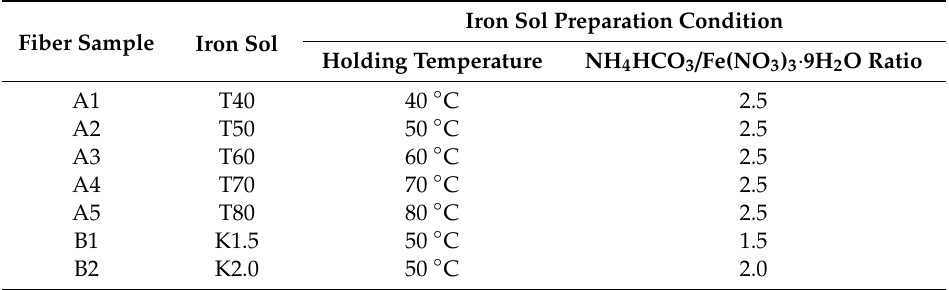
Table 1. Samples prepared in this